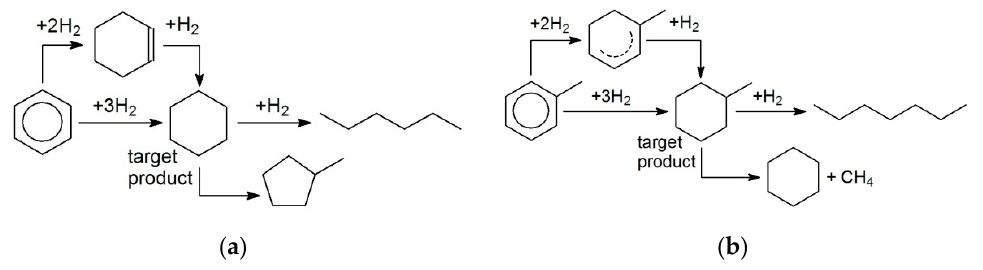
Figure 1. Simplified schemes of selective hydrogenation of BZ to CH ( a ) and TOL to MCH ( b